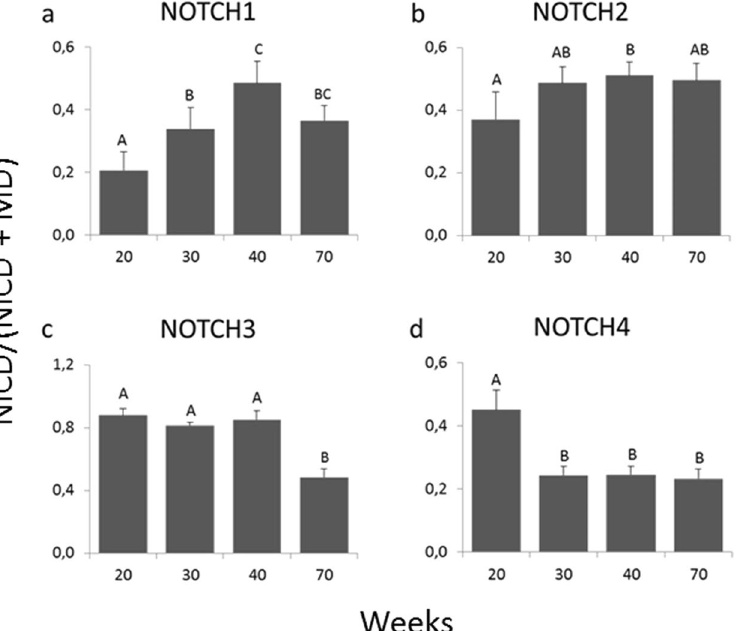
Figure 3. Relative proportion of the active domain over total receptor (NICD/(NICD + MD)) for NOTCH1–4 in mammary glands of heifers at 20, 30, 40 and 70 weeks of age (n = 6, 10, 10, 10 (a) ); (n = 7, 10, 10, 9 (b) ); (n = 10, 10, 10, 7 (c) ); (n = 7, 7, 7 6 (d) ). Different letters on the top of the bars denote statistical differences between